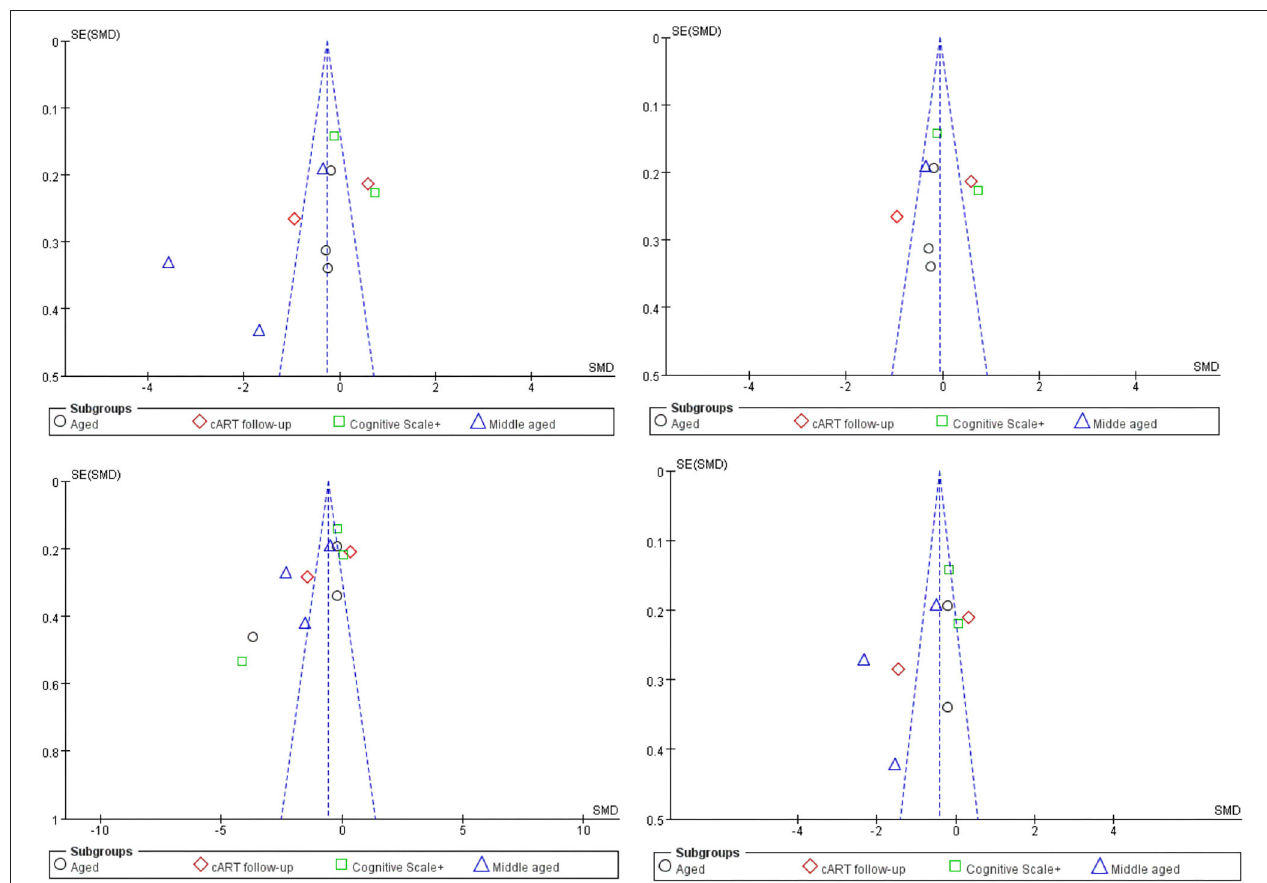
FIGURE 3 | Funnel plot of meta-analysis results. These four figures represent FA in CC, FA in CC except (37, 56), FA among other WMF, FA among other WMF [except ( 35, 39)].